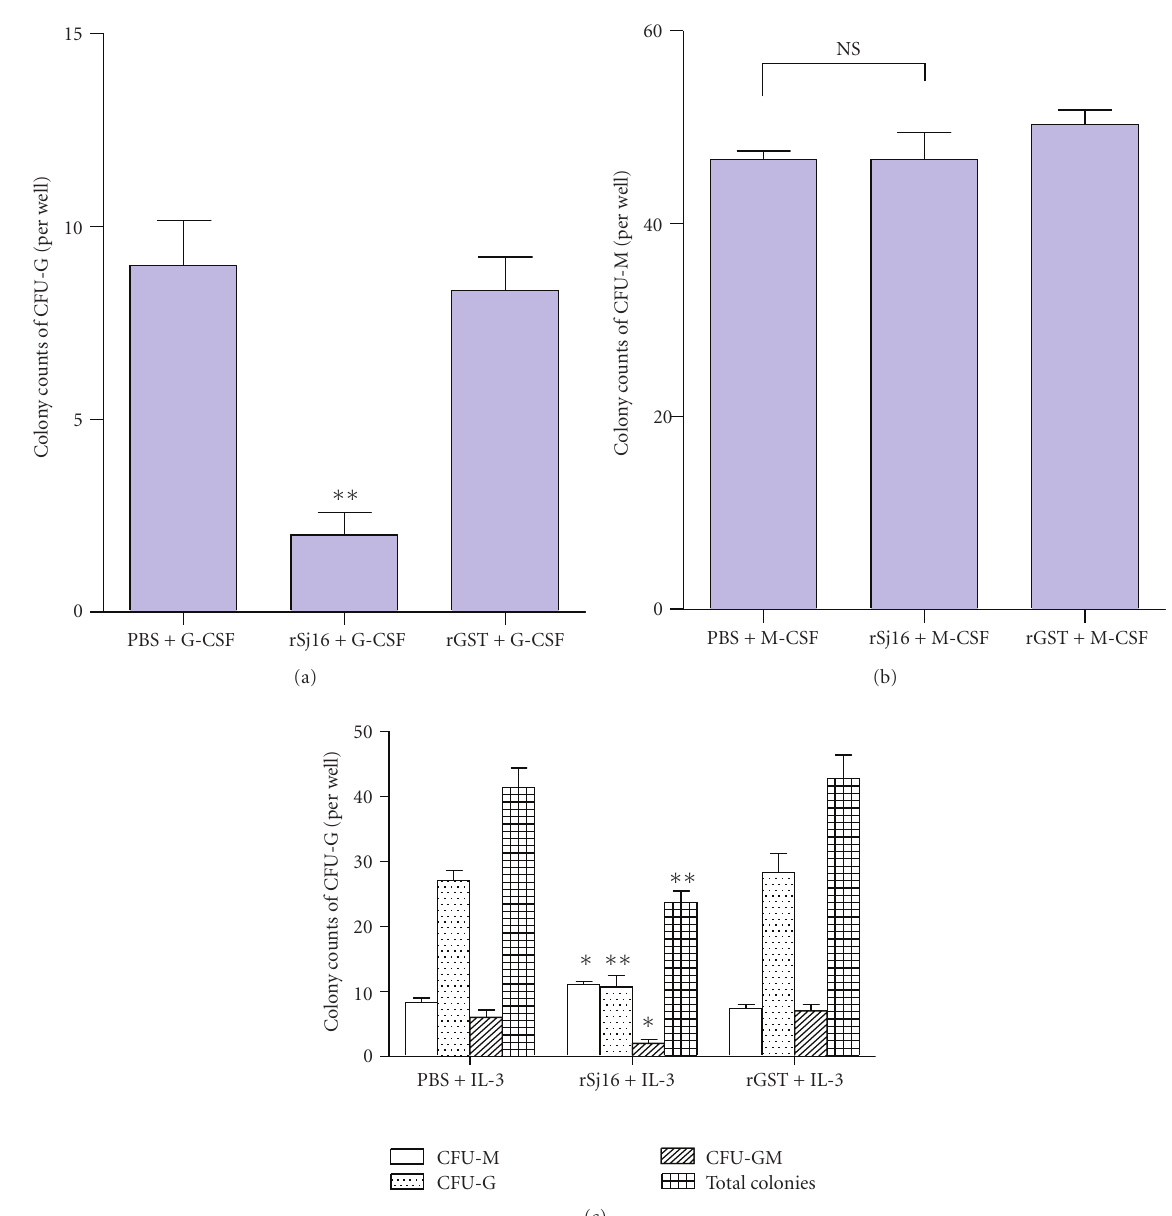
Figure 7: E ff ect of rSj16 on IL-3, M-CSF, or G-CSF induced colony formation of mouse bone marrow cells. Mouse bone marrow cells were plated in 0.33% agar cultures containing G-CSF (a), M-CSF (b), or IL-3 (c) in the presence of rSj16, rGST, or PBS in 24-well plates. The agar gels were dried and stained with hematoxylin solution following seven days of incubation. Di ff erential colony counts were performed based on the morphology of the cells, and only colonies of greater than 40 cells were counted. Colony counts are indicated as number of colonies per well. Data are mean ± SEM of triplicate wells and are representatives of three individual experiments. ∗ P < . 05; ∗∗ P < . 01; NS, not significant versus the corresponding data in the PBS + G-CSF/M-CSF/IL-3